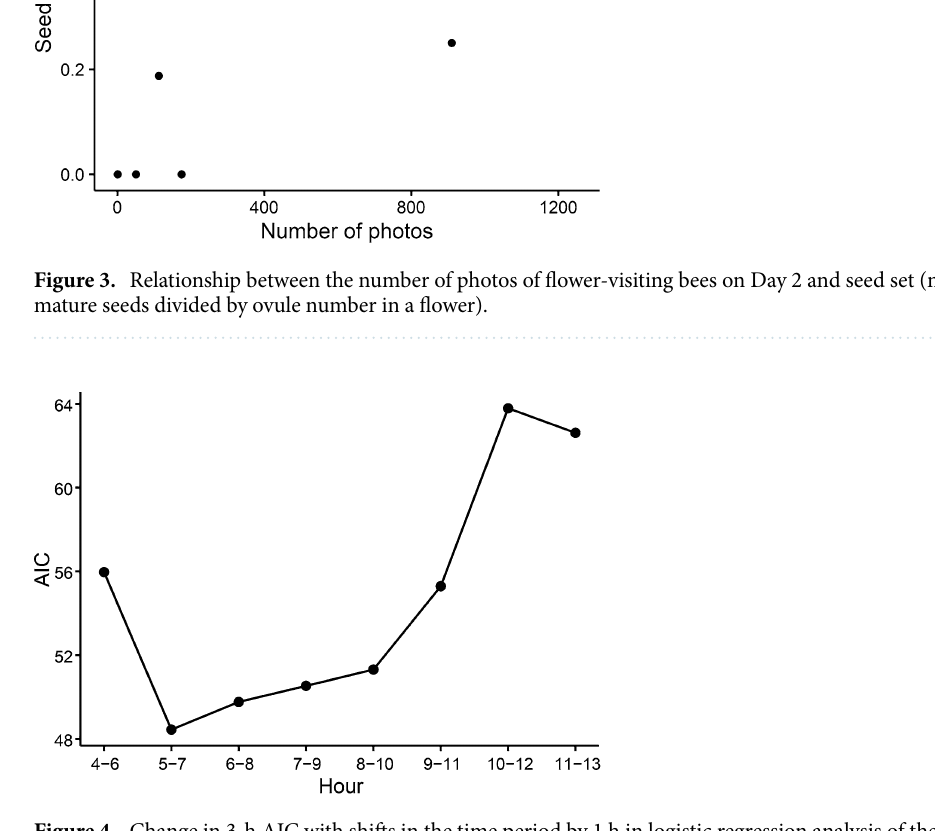
Figure 4. Change in 3-h AIC with shifts in the time period by 1 h in logistic regression analysis of the effect of the number of bees photographed on Day 2 on seed set. The pollinator group and Day were selected by former analysis that contributed to seed set of lotus flowers in this study. Lower value of AIC indicates more effective time period of visitation to seed set.